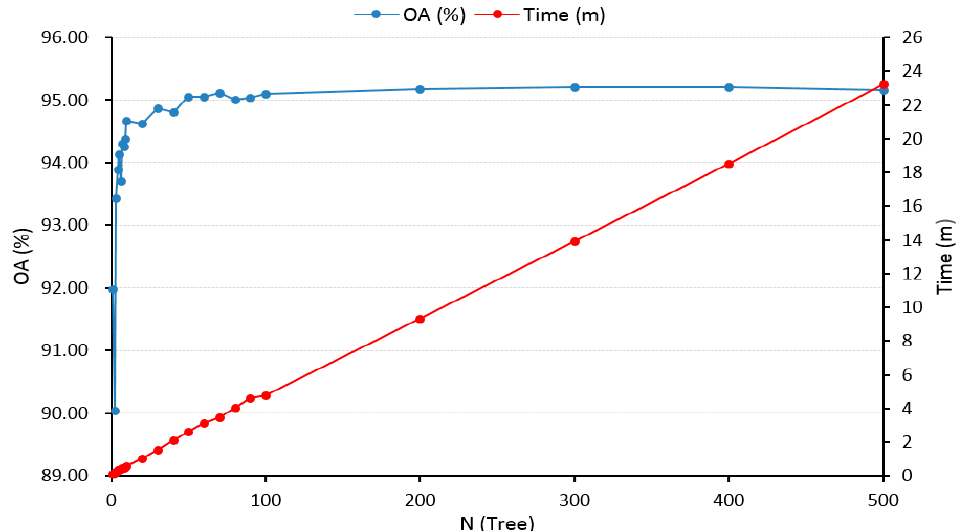
Figure 8. Effect of decision tree number on overall classification accuracy and modeling time in the RF model used in this study.